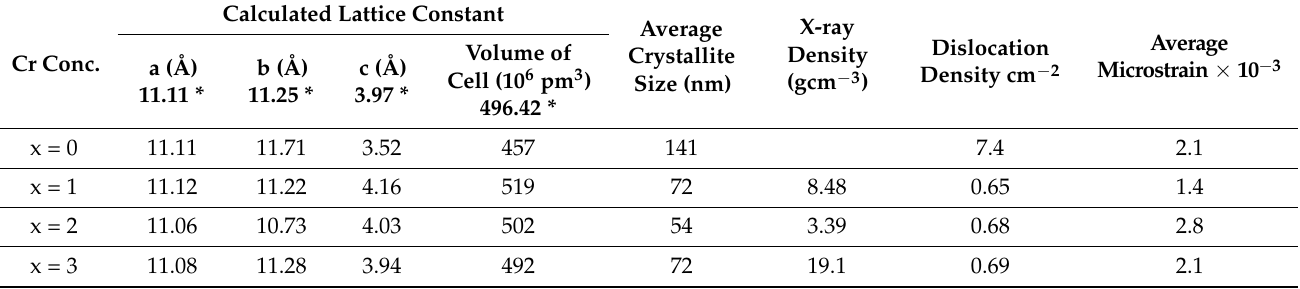
Table 1. Crystallographic parameters calculated from XRD data for thin films.